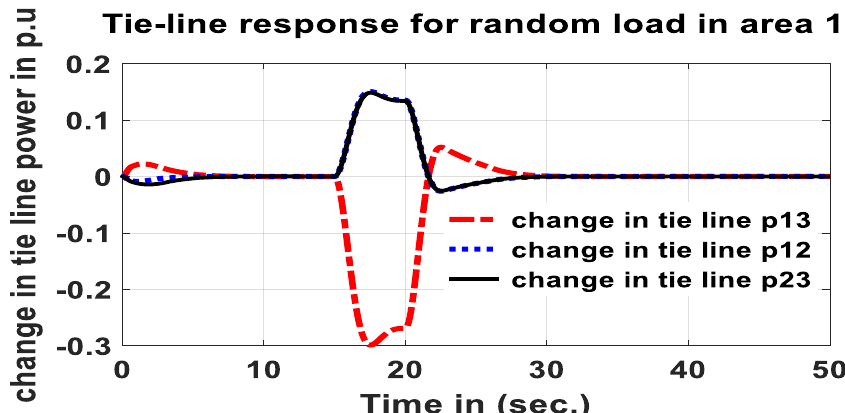
Figure 22. Change in tie-line responses of area 1, area 2, and area 3 for random load change in area 1 only.